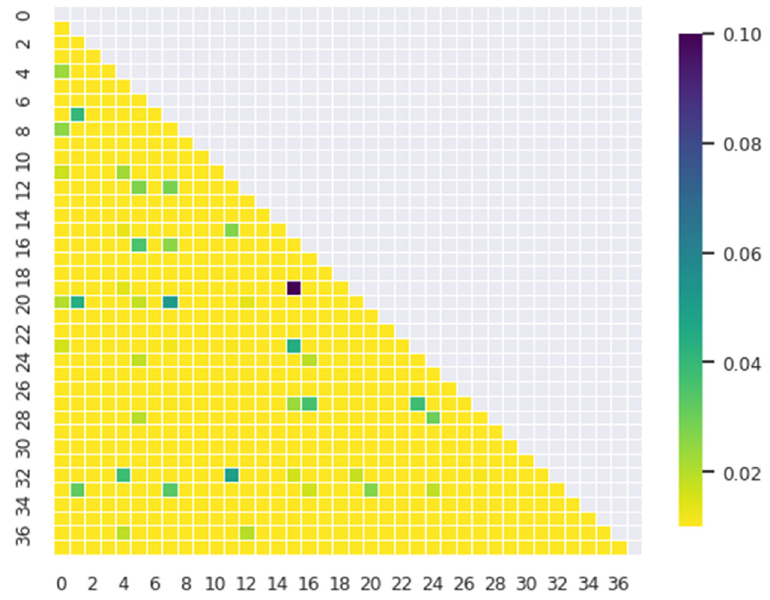
Figure 11. Heat map for similarity analysis.